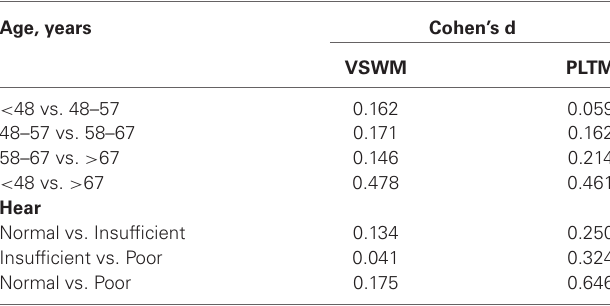
Table 4 | Effect sizes (Cohen’s d) for VSWM and PLTM between adjacent levels and the highest vs. lowest levels of Age and Hear, for the same analyses shown in Table 3 and Figure 1.